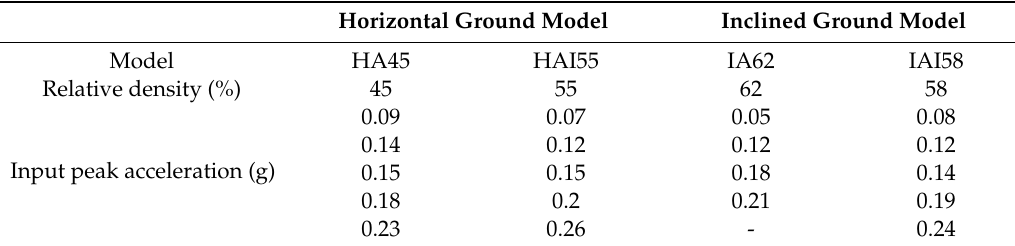
Table 3. Seismic motion input for each model.